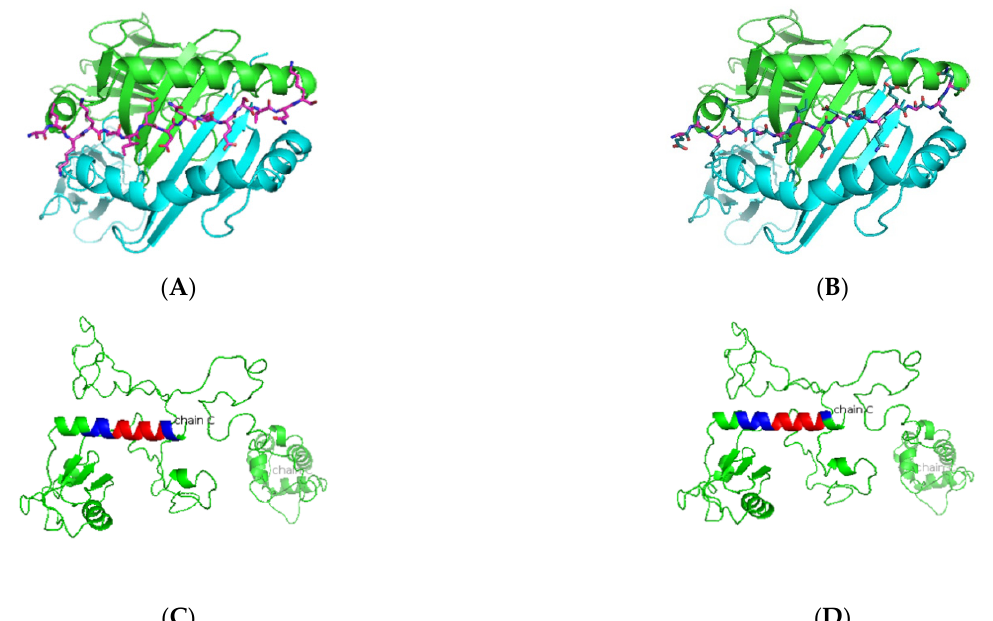
Figure 3. Predicted La peptide binders docked on HLA-DRB1*0103. ( A , B ) SMM-align predicted top two peptides ALKKIIEDQQESLNK and EALKKIIEDQQESLN with IC50 values of 49 and 50 were docked onto the crystal structure of HLA-DRB1*0103 PDB structure 1A6A, and the most optimum predicted position of docking is indicated. Both predicted peptides have the same core sequence IIEDQQESL. ( C , D ) The highlighted region indicates the presence of the peptide in the three-dimensional structure of the La protein.